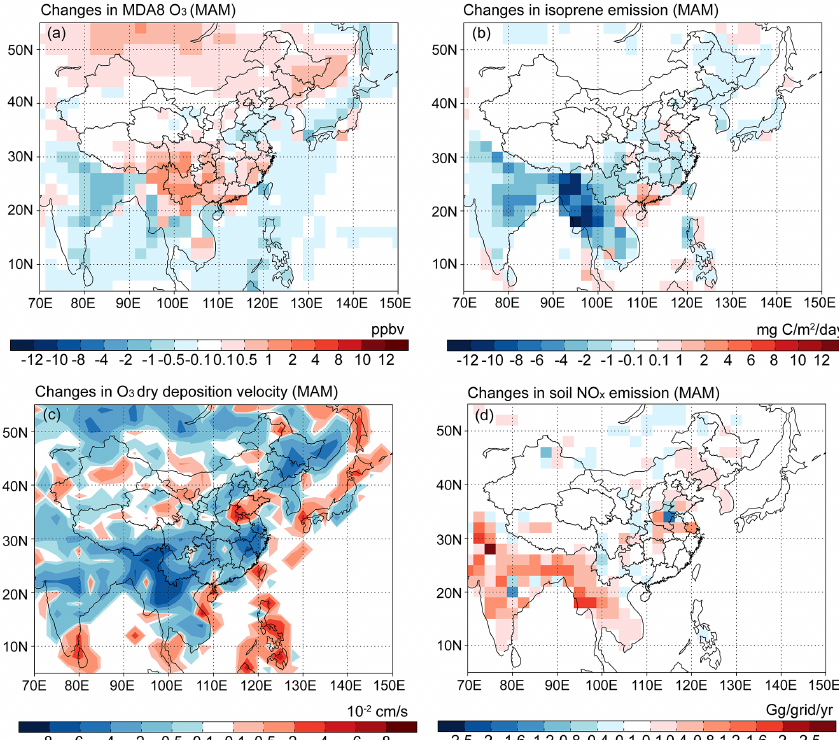
Figure 3. Changes in springtime (MAM) (a) surface maximum daily 8-h average ozone concentration (MDA8 O 3 ) ; (b) isoprene emis- sion; (c) ozone dry deposition velocity; and (d) soil NO x emission driven by 1980–2010 changes in land cover and land use alone ([CTRL] − [SIM_LCLU]). Values are differences between the 5-year averages over the present-day and historical